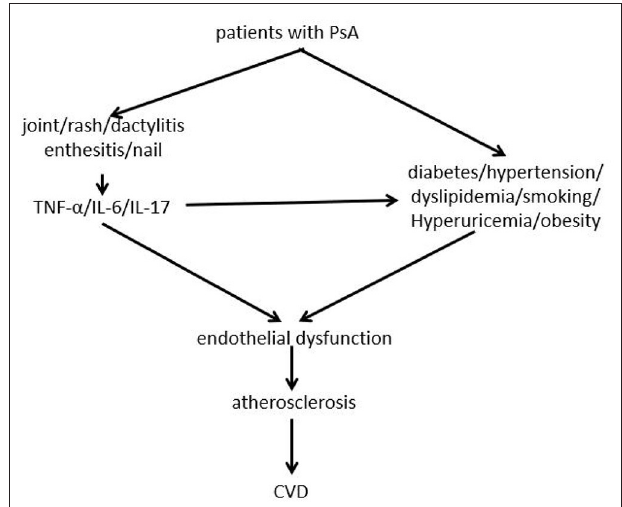
FIGURE 1 | Pathogenesis of psoriatic arthritis complicated with cardiovascular